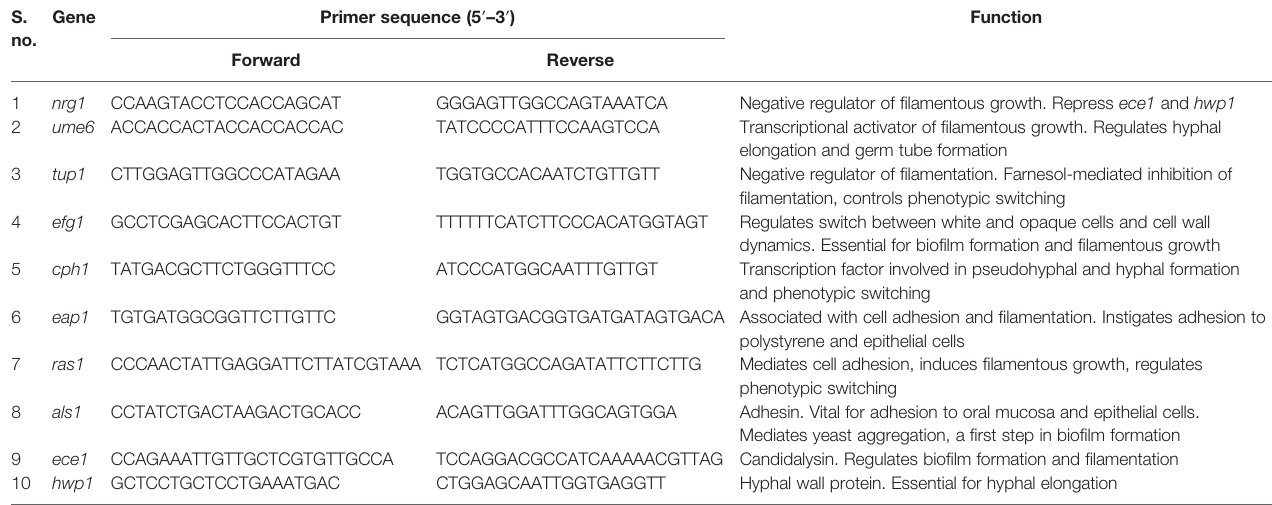
TABLE 1 | Candidate genes, primer details and function in the virulence and pathogenicity of C. albicans . S. Gene Primer sequence (5 ′ – 3 ′ no.